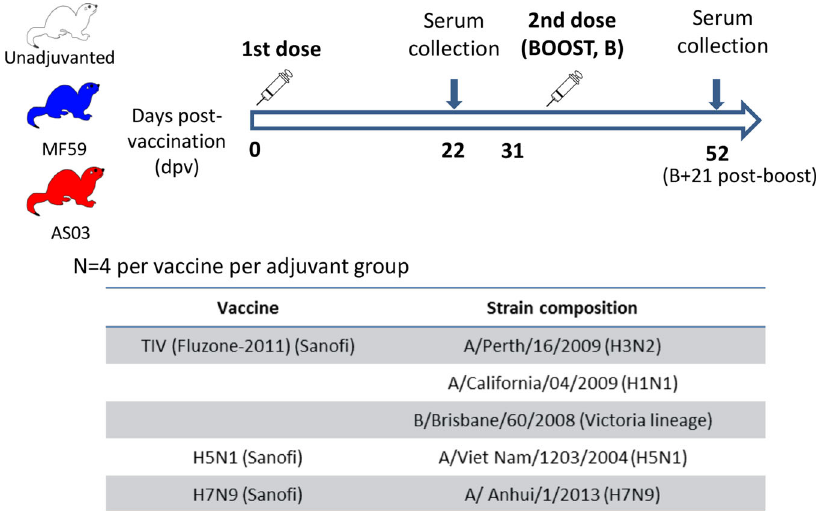
Fig. 1 Immunization schedule and vaccine groups. Each ferret received 7.5 µg of hemagglutinin (HA) protein per vaccine strain per dose. Graphics depicted in this fi gure were generated